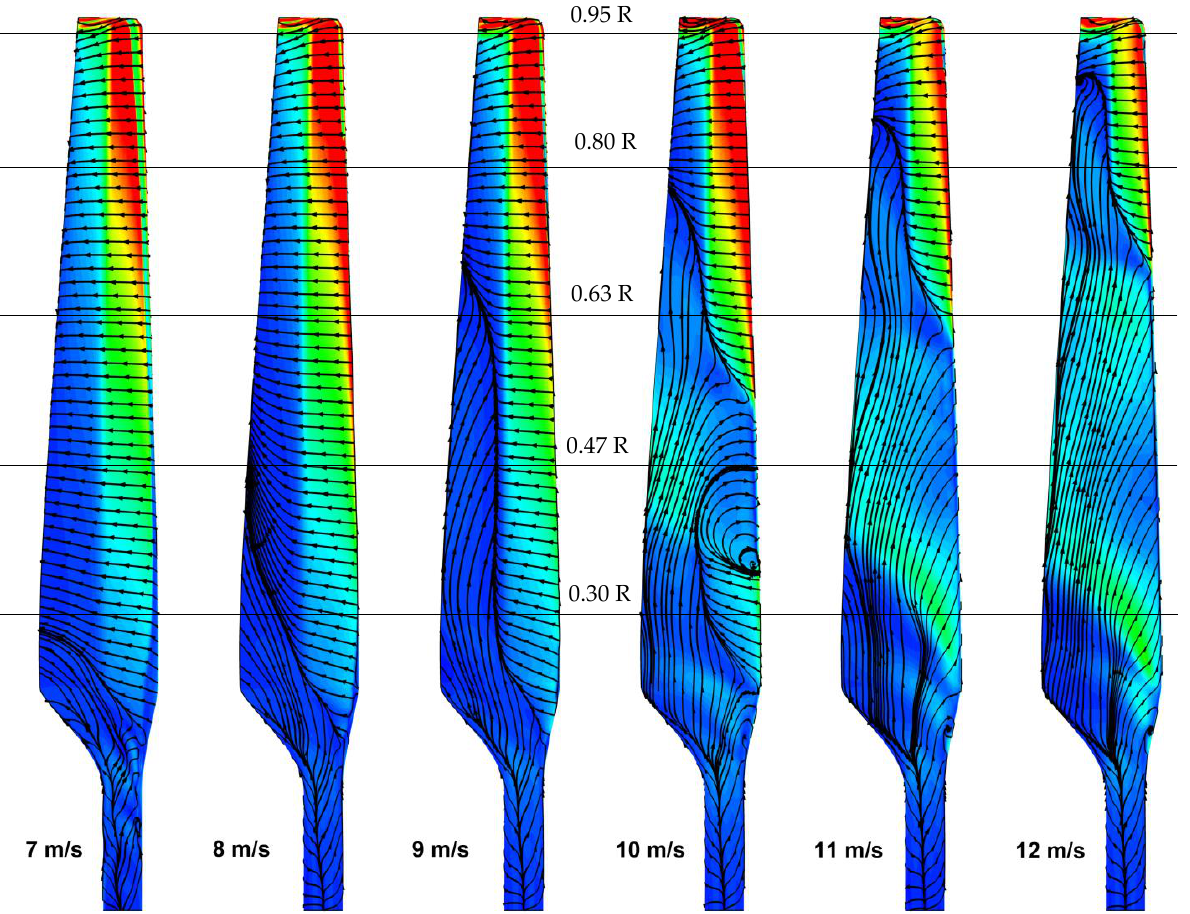
Figure 14. Wall shear stress magnitude contours overlaid with surface streamlines on the blade suction side demonstrating the development of three-dimensional rotational flow effects and stall initiation between 7 and 12 m/s wind speed. The five pressure measurement sections can be located using the horizontal lines. The WSS magnitude range is (0.5) Pa.